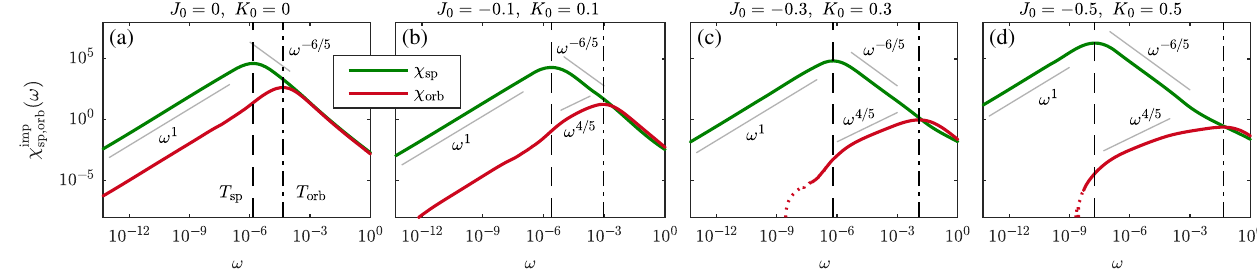
K 0 . 5 . The energy scales for spin and 0 ¼ 0 ¼